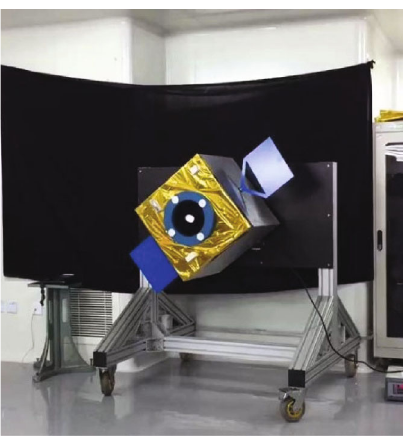
Figure 11: Schematic diagram of the satellite model and the experimental scenario.